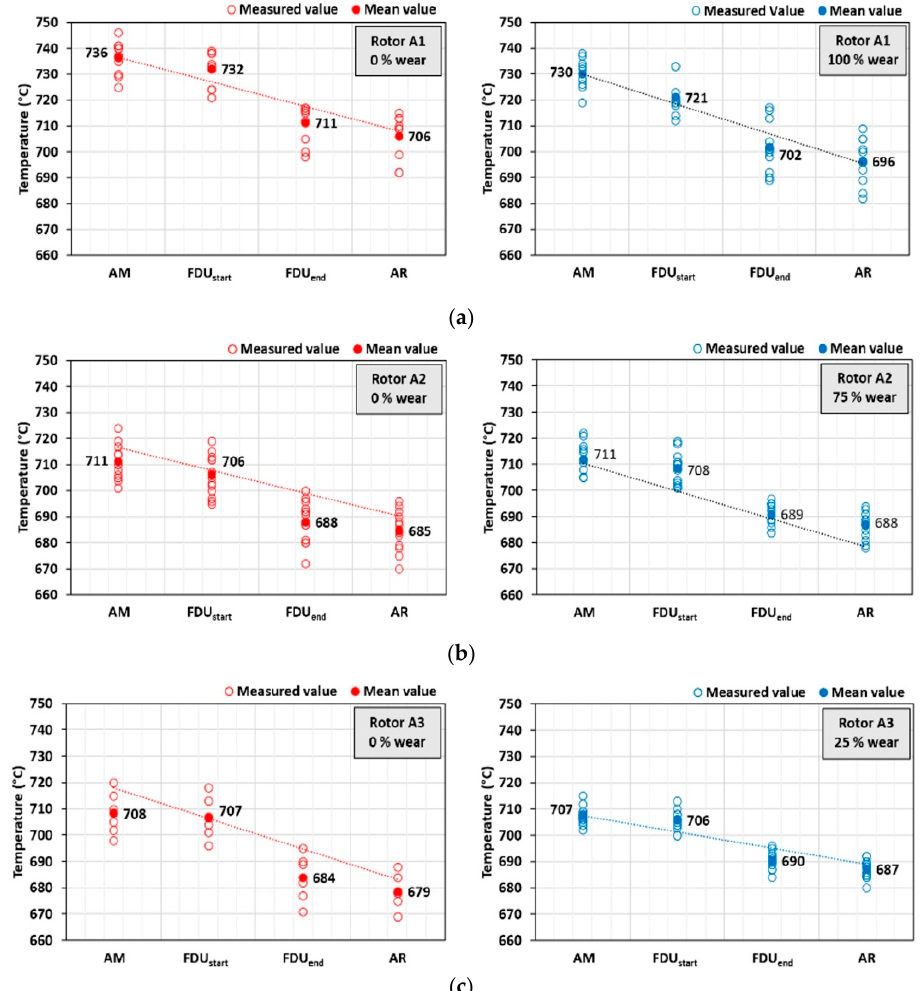
Figure 8. AlSi9Cu3(Fe) melt temperature drop during production (from melting to refining): ( a ) rotor A1 (series 1/VT and 5/VT), ( b ) rotor A2 (series 1/VT and 4/VT), ( c ) rotor A3 (series 1/VT and